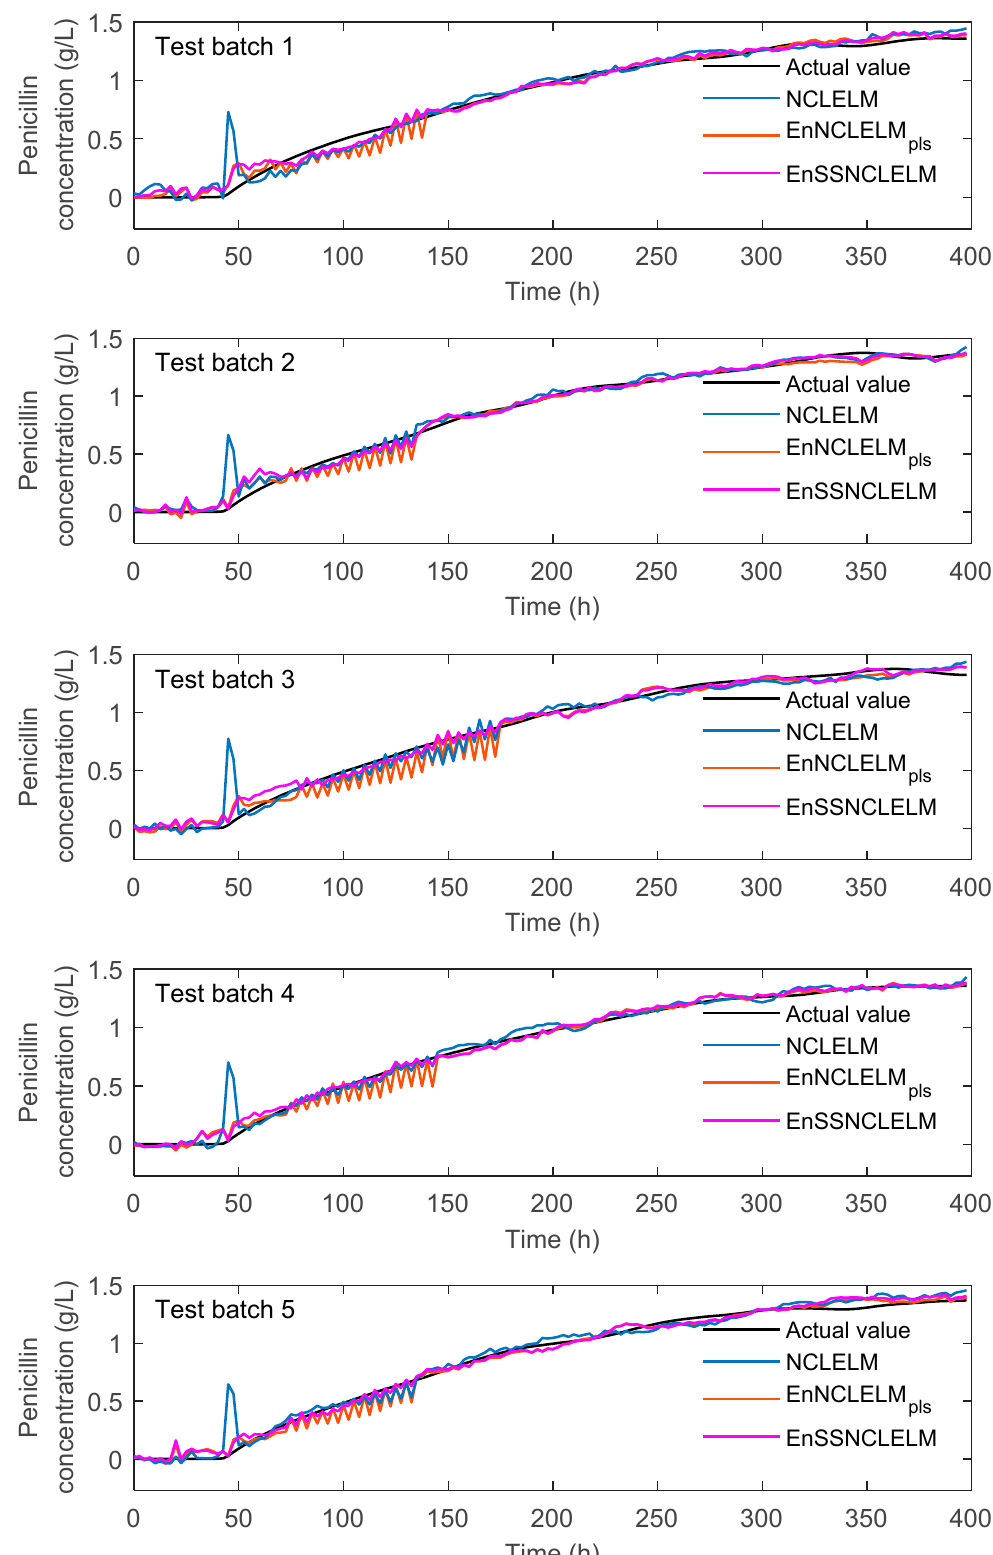
Figure 6. Trend plots of penicillin concentration predictions using ELM, EnNCLELM pls , and EnSSNCLELM methods in penicillin fermentation process.